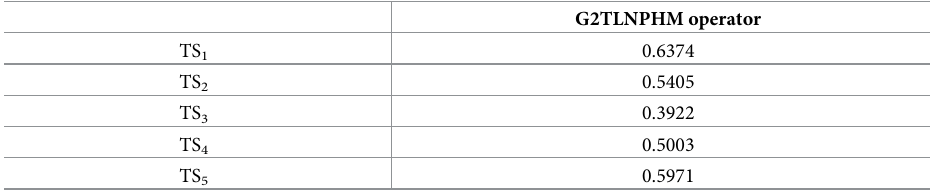
Table 3. The score functions.